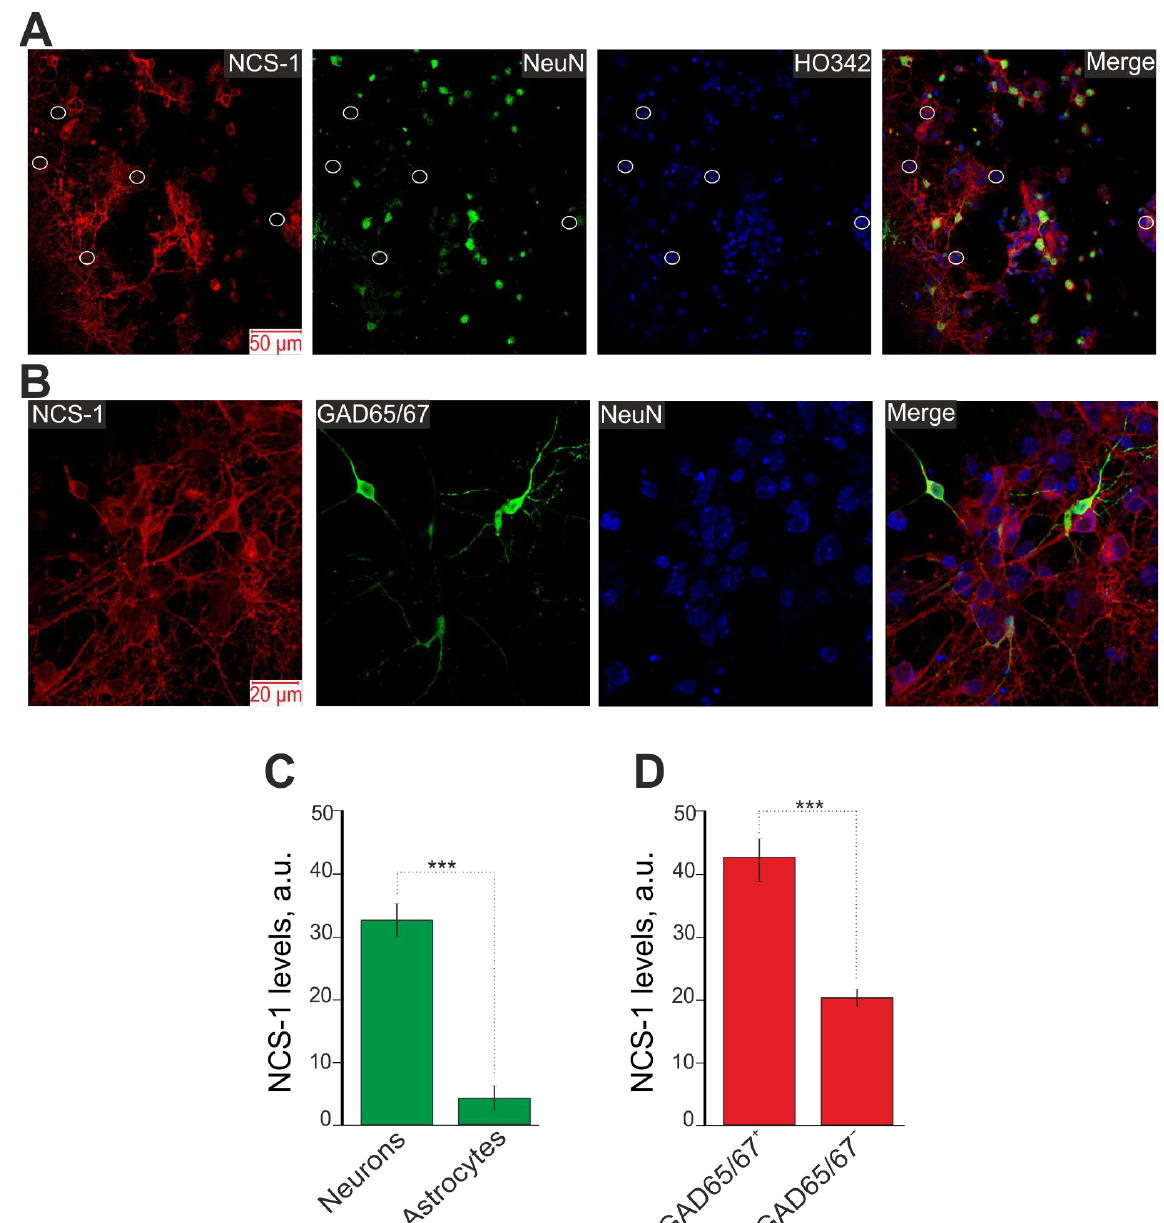
GAD65/67 − and GABAergic neurons of the cerebral cortex (Figure 2A – C), as well as to a two-fold increase in the level of Ripk1 expression, compared with control, which indicates increased necrosis in the experimental group (Figure 3C).